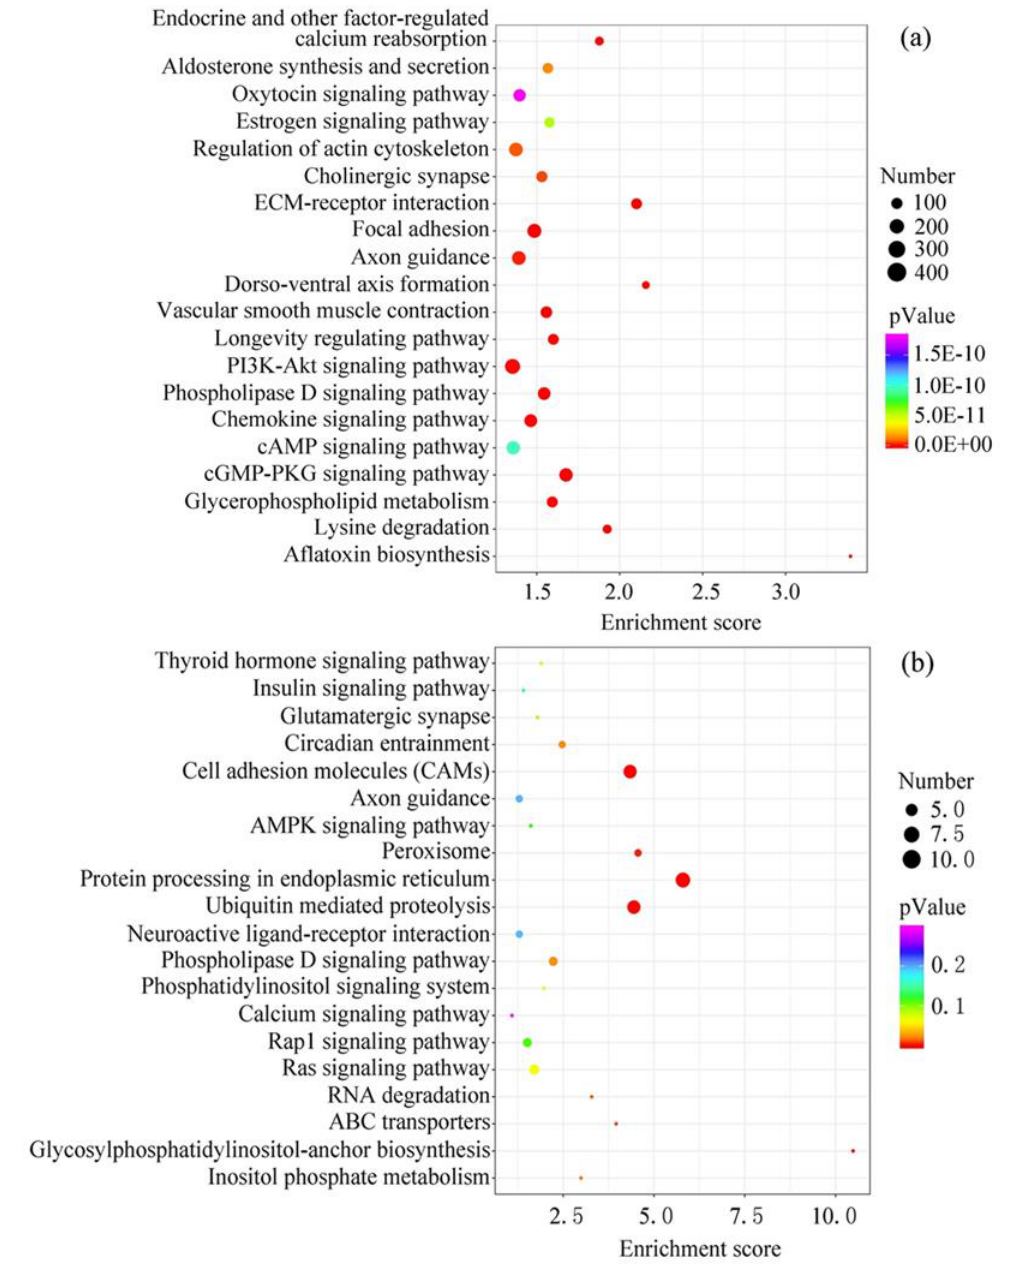
Figure 4. KEGG pathway analysis of the target genes of the top 20 EV-miRNAs. ( a ) Cow milk. ( b ) Sheep milk.